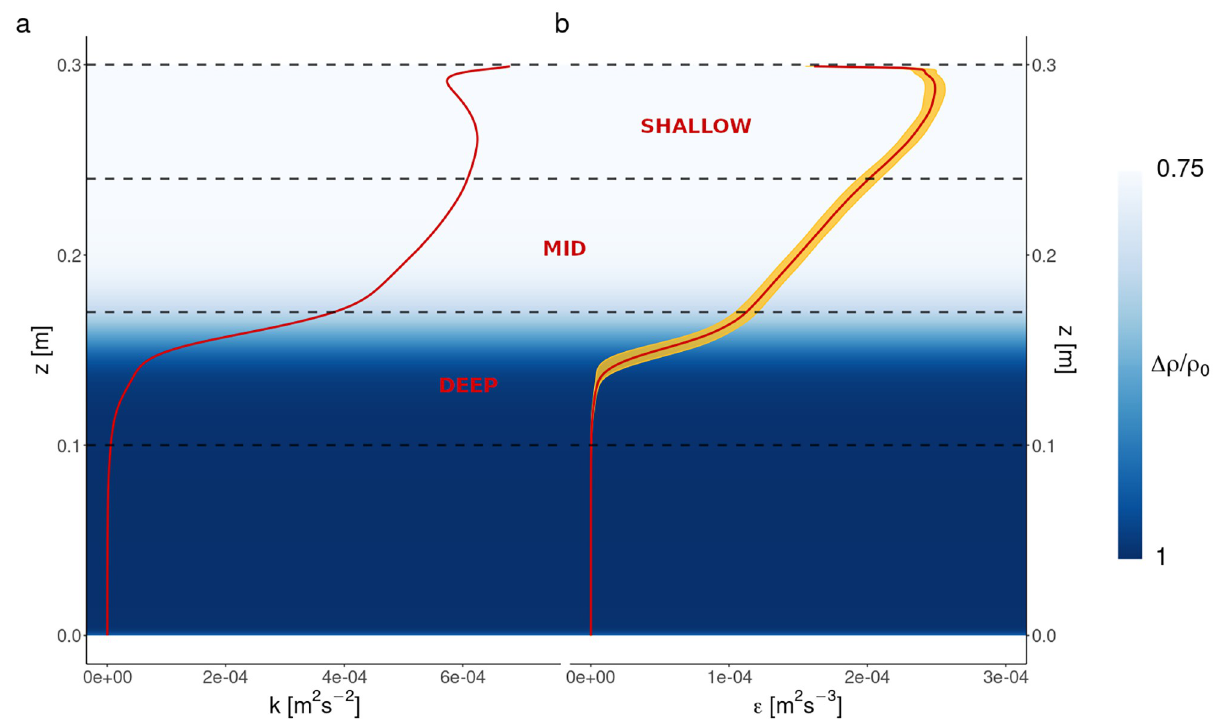
Fig 1. Depth structure of the simulated flow. The white-blue gradient represents the density gradient of the fluid ( Δ ρ / ρ 0 = ( ρ − ρ 0 )/ ρ 0 ), where ρ 0 is the reference density ρ 0 at z = 0). (a) Turbulent kinetic energy ( k ) vs depth in the fluid DNS. The red line denotes the mean value of k at all simulated depths. (b) Turbulent dissipation rate ( � ) vs depth in the fluid DNS. The red line denotes the mean value of � at each simulated depth, while the golden ribbon shows the variance of � at each depth. Variances are not known for panel (a) since k is itself computed from the variances of the fluid velocities. The Shallow, Mid, and Deep depth regions are labelled in red text and delimited by black dashed lines. Turbulence was strongest near the fluid surface and declined with depth, with essentially quiescent waters below the density